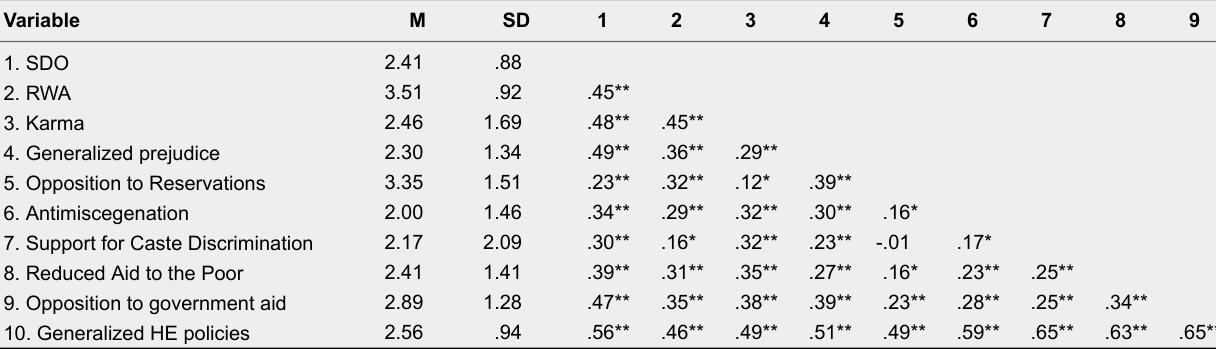
Means, Standard Deviations, and Intercorrelations Among the Raw Composite